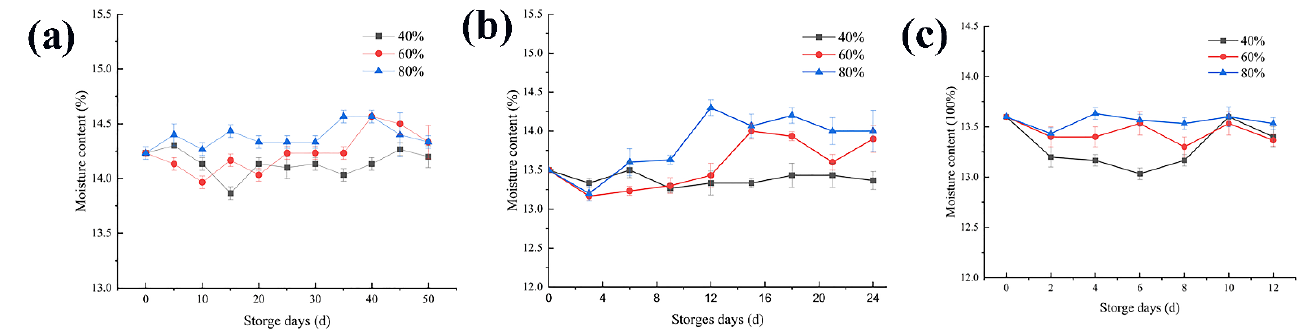
Figure 1. Changes in the rice moisture content at different storage temperatures: ( a ) 20 °C, ( b ) 30 °C, and ( c ) 35 °C .